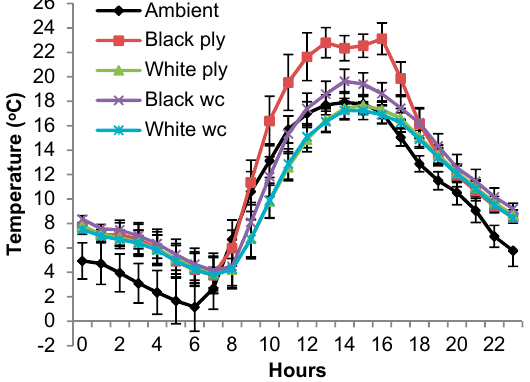
Figure 6. Warmest chamber mean (±SE) temperature in each box design and ambient temperature over 24-h. Hourly means are for the 5-day winter period. ply = plywood; wc = wood-cement.